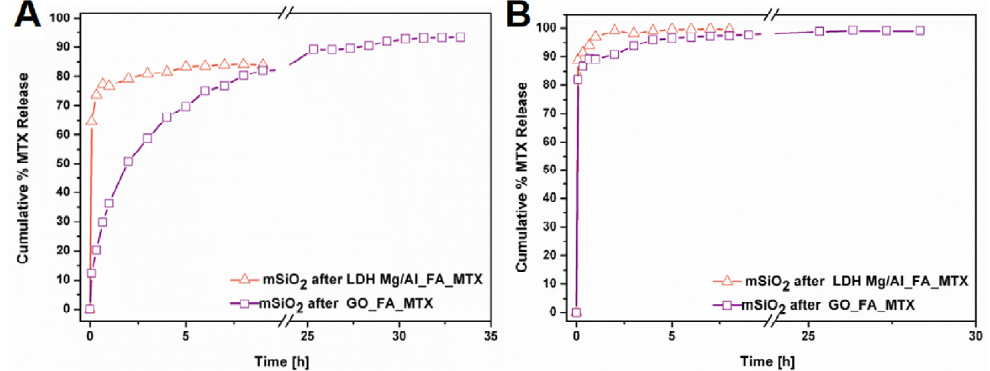
Figure 6. MTX releasing profiles in water ( A ) and phosphate-buffered saline (PBS) solution ( B ) at 37 °C.